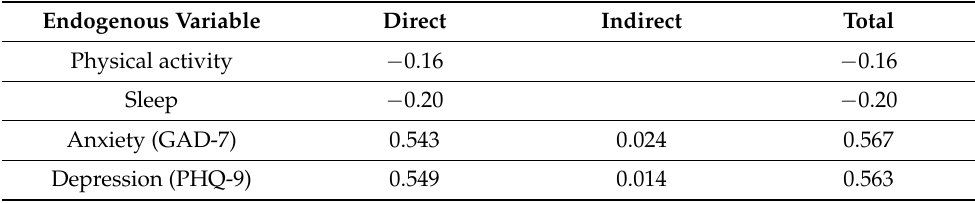
Table 3. Decomposition of standardized direct and indirect effects of academic